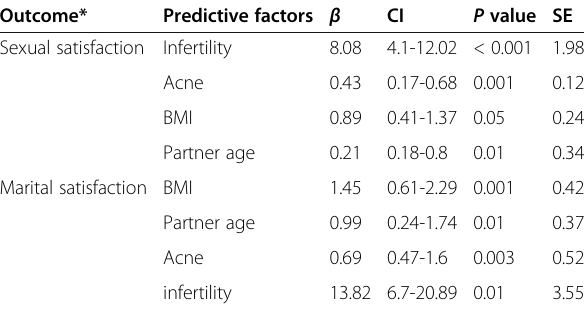
Table 3 Predictive factors of marital and sexual satisfaction in couples with PCOS